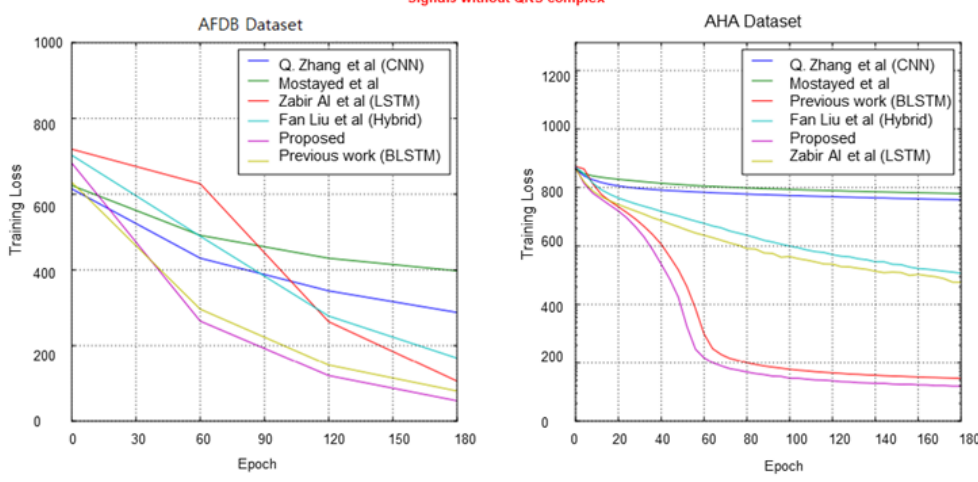
Figure 12. Comparison of cross-entropy loss per epoch over AFDB dataset and AHA